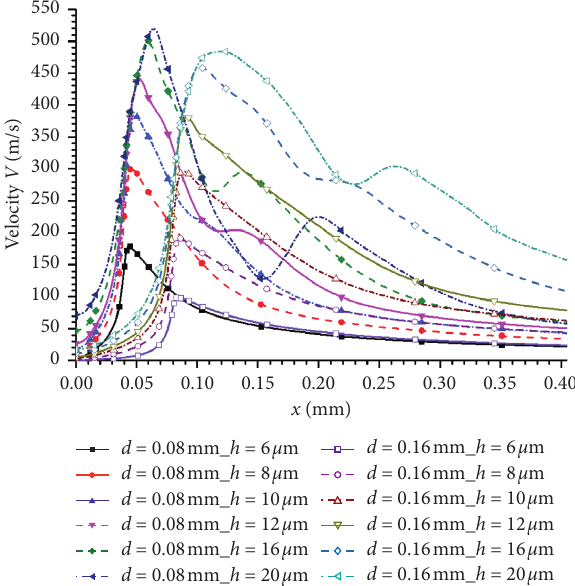
Figure 11: Curves D 2 of the velocity of the gas film at different h .